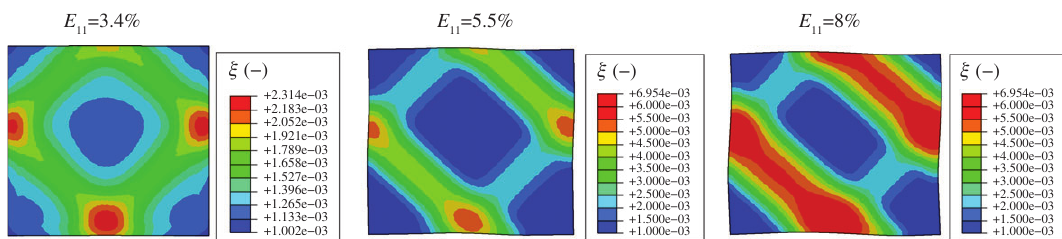
Figure 15 Sample S , variation of initial defect: spatial distribution of free volume ξ at different applied strains E 2 Initial defect at the right edge slightly above horizontal center (see Figure